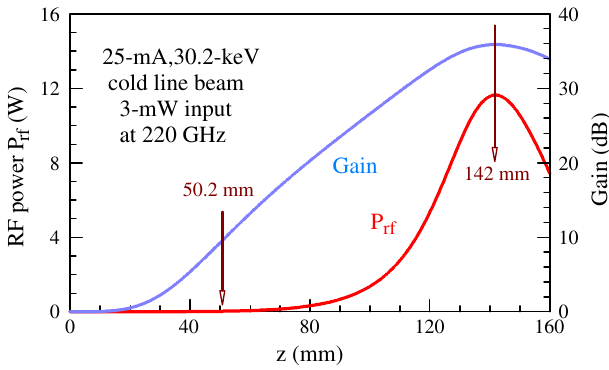
FIG. 5. (Color) Dependence of rf power P and gain on axial rf distance z for a rectangular dielectric-loaded TWT with a 25- mA, 30.2-keV cold line beam and a 3-mW input power of 220 GHz. The linear growth rate at z (cid:3) 50 : 2 mm is 46 : 0 = m , and the rf power reaches saturation (11.6 W) at 142